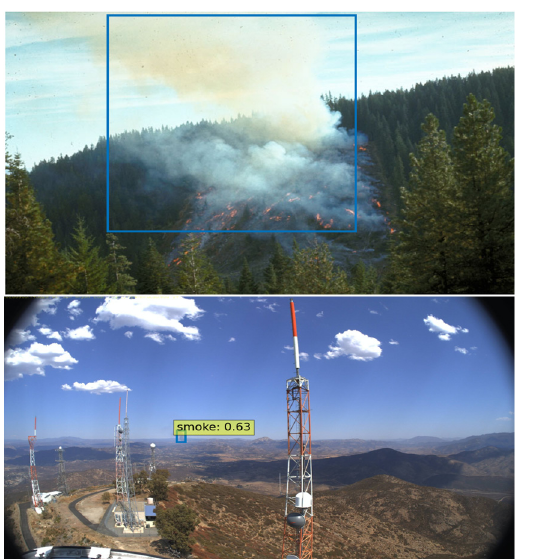
Figure 8. Detection results using YOLOv5s.